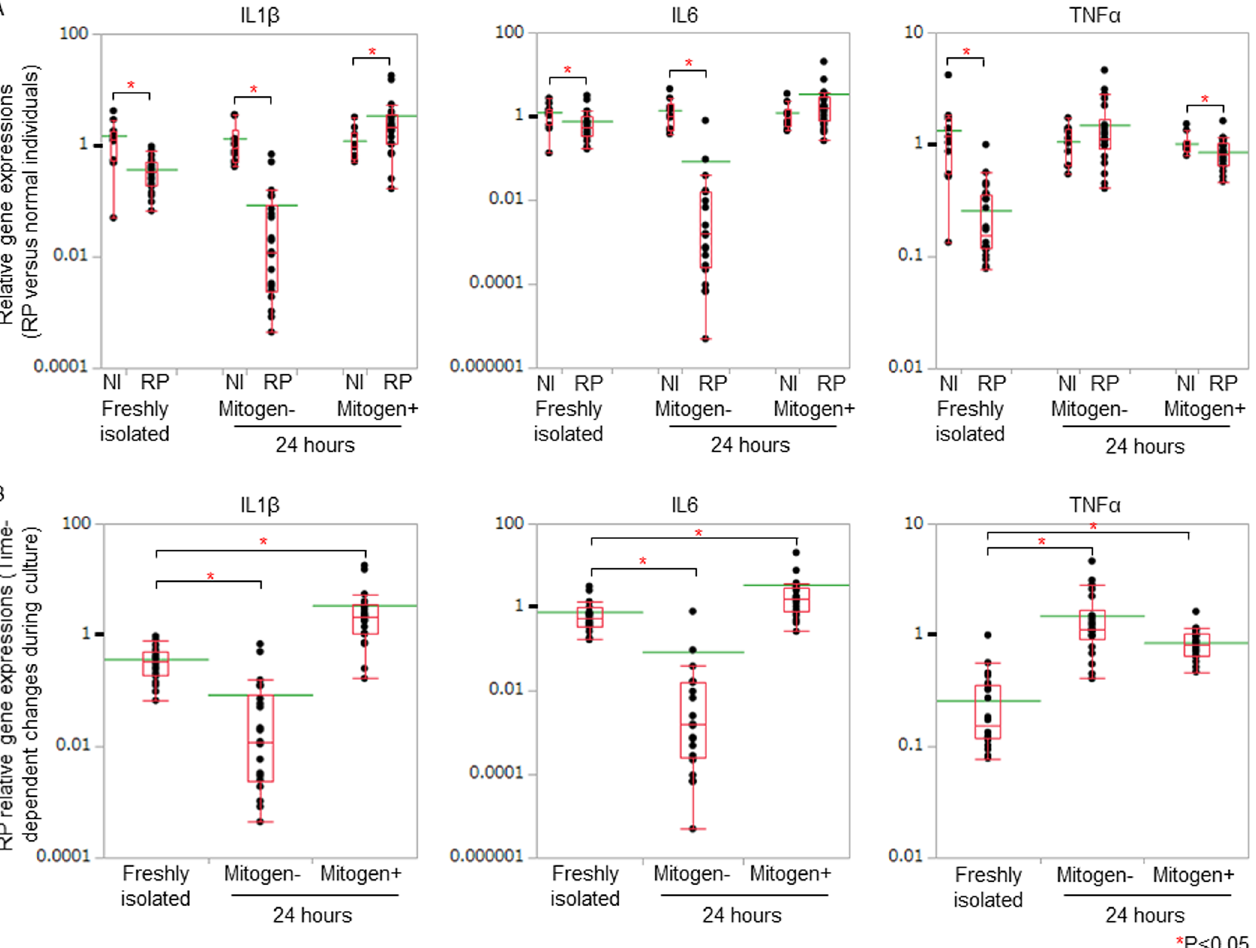
Fig 5. Inflammatory cytokine gene expressions in PBMC of RP patients. (A) We assessed RP relative gene expressions of inflammatory cytokines by normalizing the titers to 2 - ΔΔ Ct of normal individuals. The gene expression levels of normal individuals were defined as 1.000. IL1 β gene expressions of RP patients were significantly higher than those of normal individuals in the presence of mitogen stimulation, 24 hours after the initiation of the cell culture. (B) We compared the gene expression data of the freshly isolated PBMC with those of cultured PBMC in patients with RP. After the initiation of the cell culture, in the absence of mitogen stimulation, TNF α gene expressions increased significantly in RP patients. With the stimulation, IL1 β , IL6, and TNF α gene expressions increased significantly in RP patients. Relative gene expressions of RP patients against those of normal individuals were displayed with dot plots. A box-plot and a mean level (green line) of each group of RP patients and normal individuals were